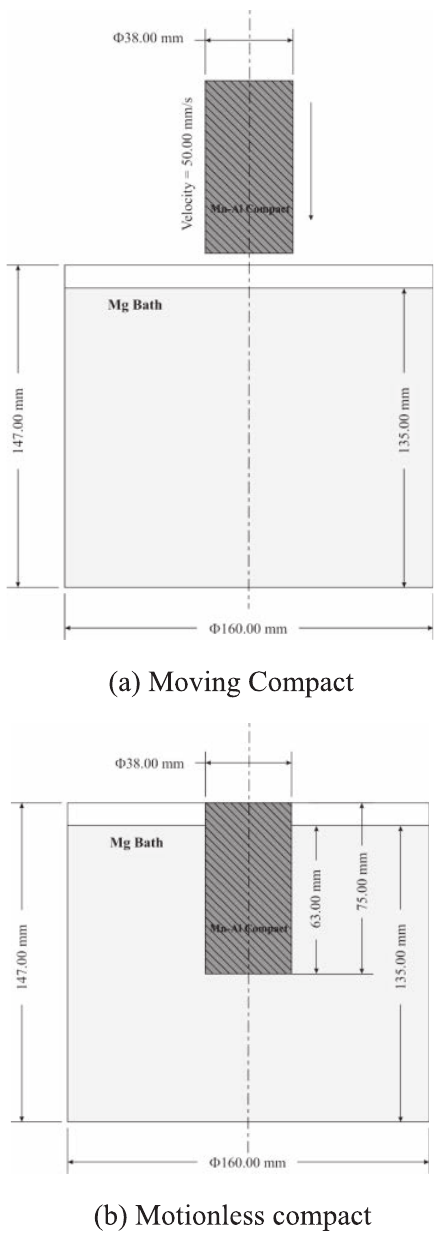
Fig. 5: Schematics for a Mn-Al compact immersion process into a Mg bath